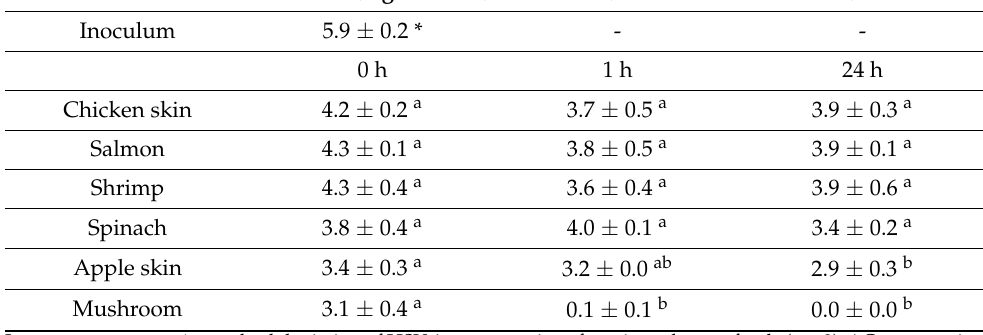
Table 3. SARS-CoV-2 Recovery from Foods. Virus Concentrations (log PFU/mL) over Time (Hours